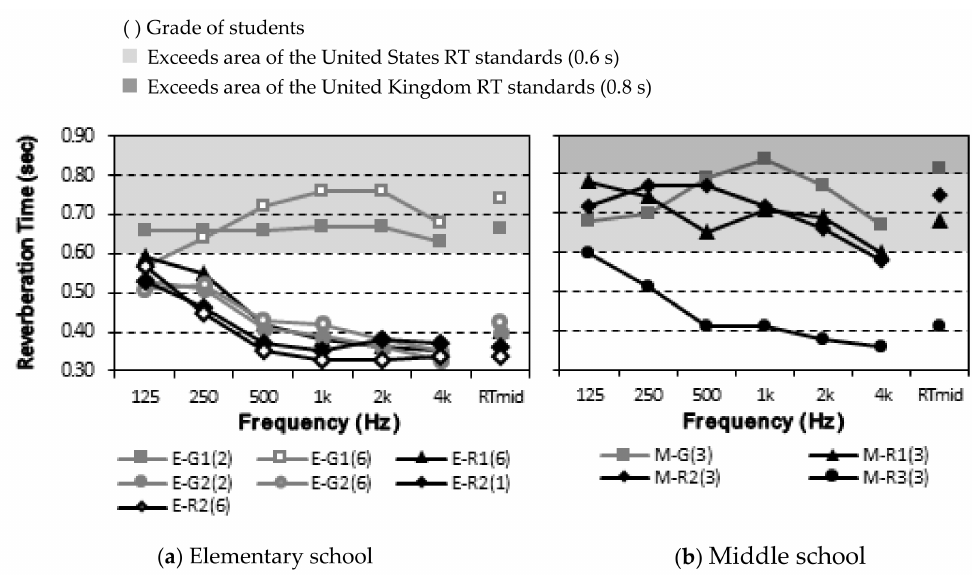
Figure 3. Measurement results of reverberation time in Korean classrooms